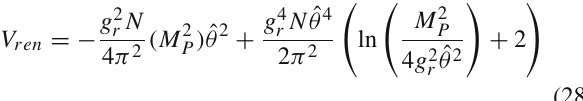
Fig. 2 The infrared theory is controlled by the neutrino loops